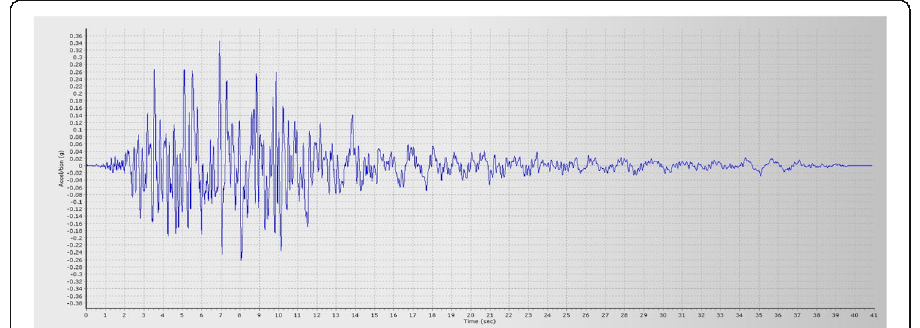
Fig. 10 Real accelerogram (Kobe, Japan, 1995)